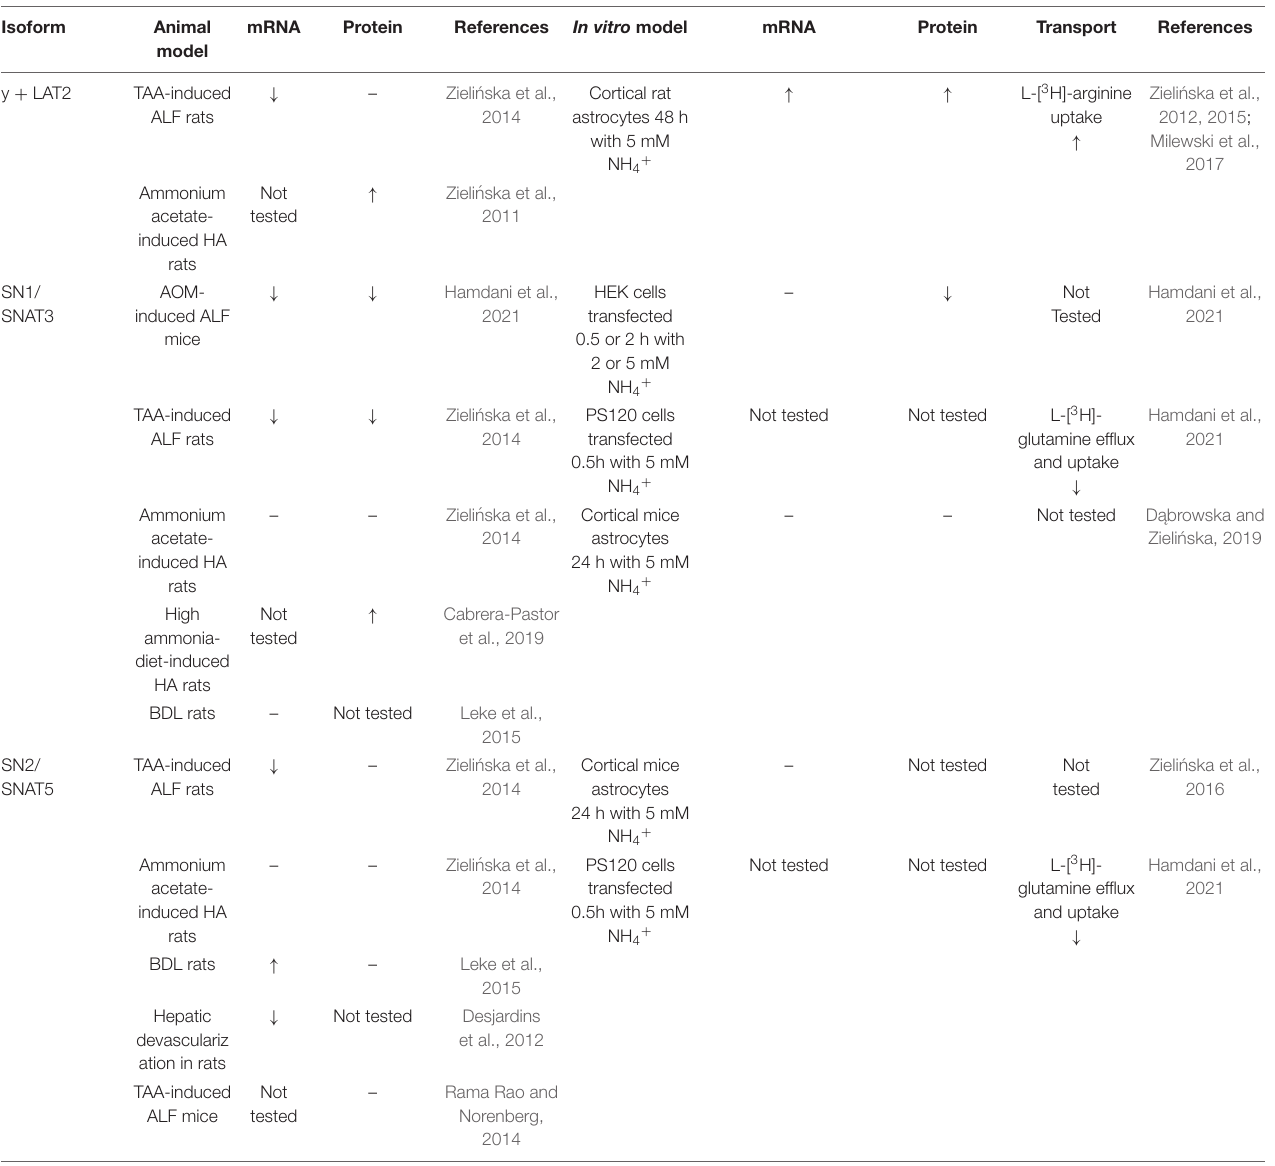
TABLE 2 | ALF or ammonia in vitro - induced alterations in astrocyte-localized glutamine transporters.